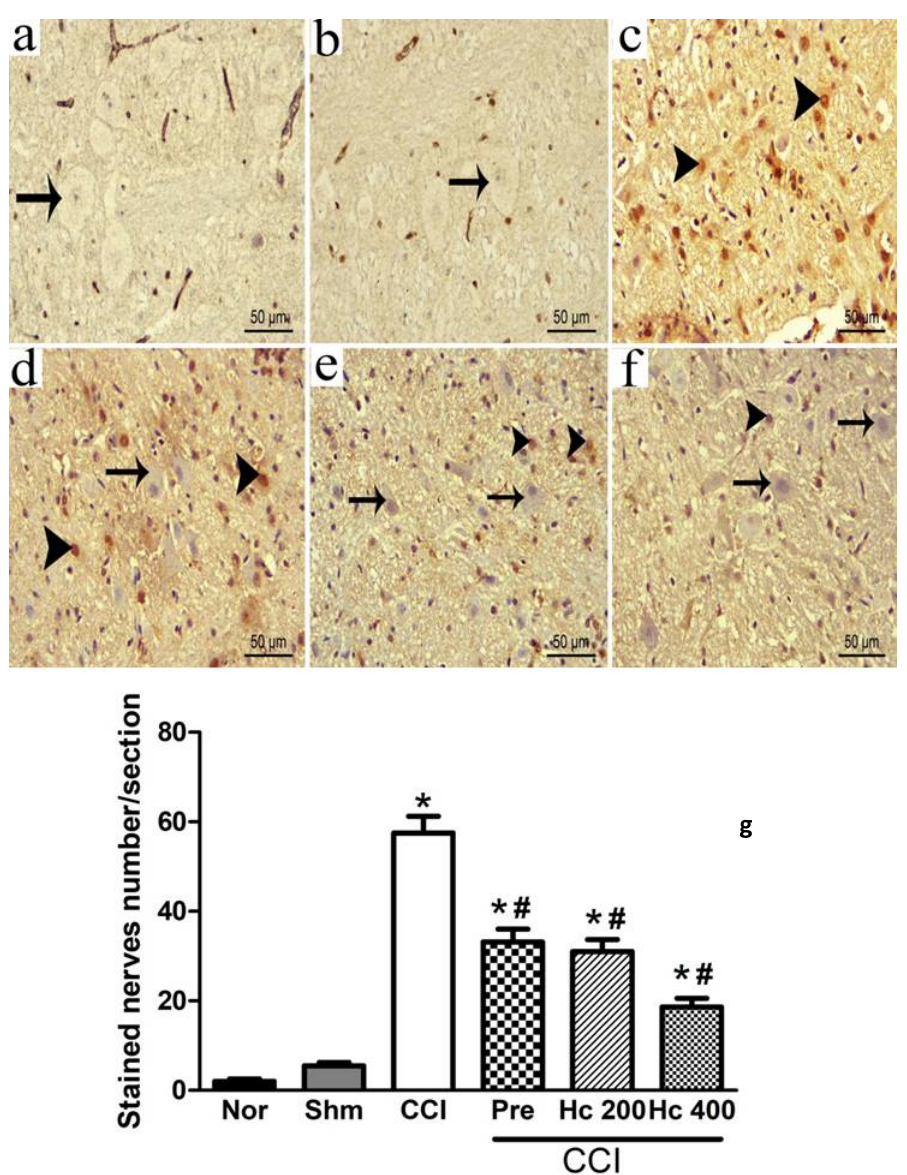
Figure 11. Representative photomicrographs revealing the apoptotic neurons expression via p53 ( a – f ) immunostaining brain stem sections in normal ( a ), sham ( b ), CCI ( c ), pregabalin ( d ) H. campechianum flower extract (p.o., 200 mg / kg) ( e ); and H. campechianum flower extract (p.o., 400 mg / kg) ( f ). Head arrow indicates dark brown staining nuclei of immunopositive neurons and the arrow indicates the negative neurons. Bar chart ( g ) shows the changes in the p53 positive neurons’ number with dark brown nuclei in the brain stem sections from all experimental groups. Counting the immunopositive neurons was conducted in 3 non-overlapping fields from 100% magnification (overall 6 animals / group). Data are presented as mean values ± S.E.M (n = 5–7). * p < 0.05 vs. normal values, # p < 0.05 vs. CCI. Scale bar 50 µ m. CCI, chronic constriction injury; Hc, H. campechianum ; Nor, normal; Pre, pregabalin; Shm, sham.